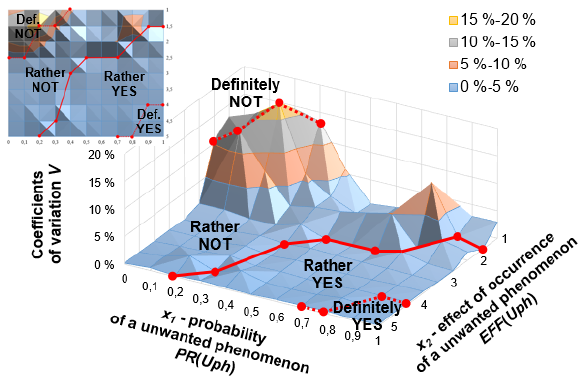
Figure 15: The map of the values of the coeflcients of variation of the output variable y depending on the value of the input variables x 1 and x